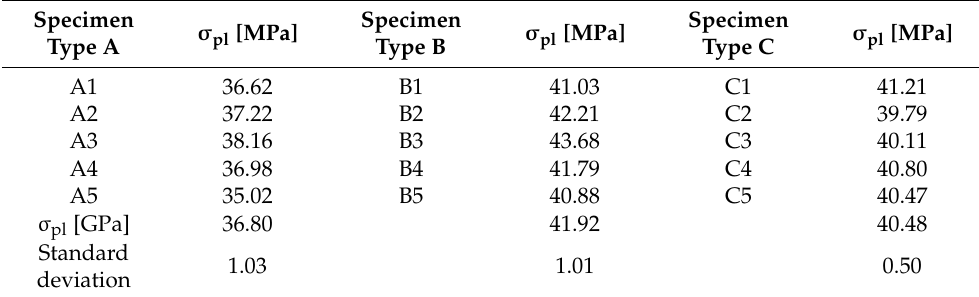
Table 3. The values of yield stress obtained for particular specimens from the tensile static test.